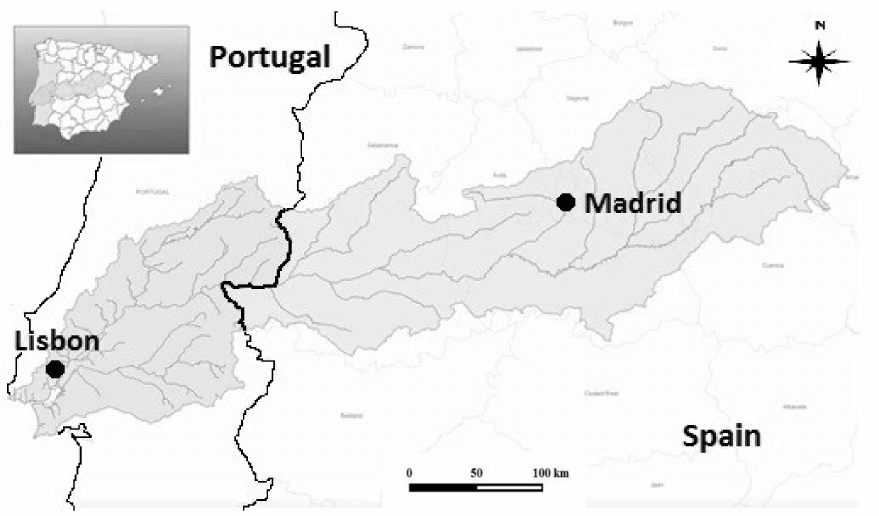
Figure 1. Tagus River Basin in the Iberian Peninsula (built with QGIS)